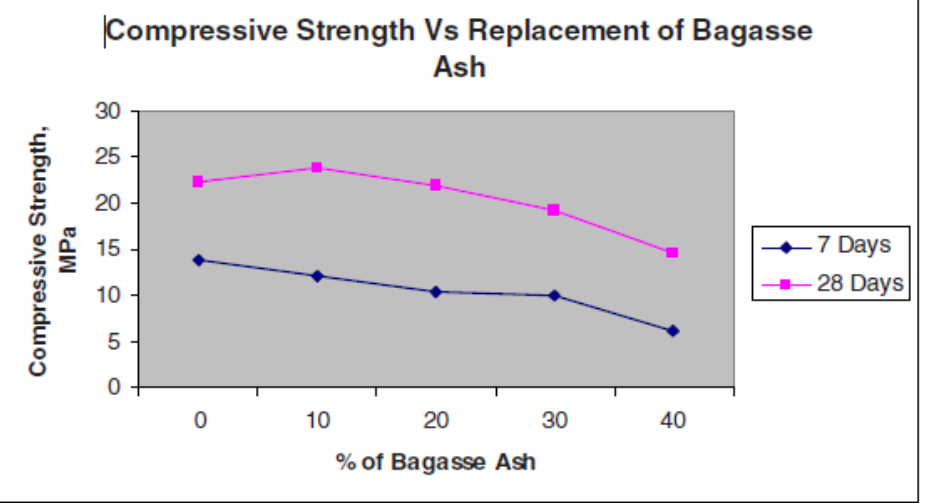
Figure 4. Compressive strength characteristic